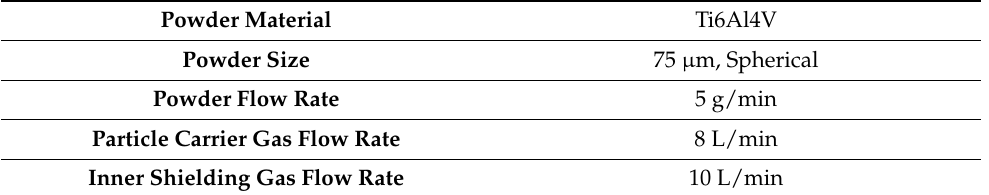
Table 2. The standard parameters.